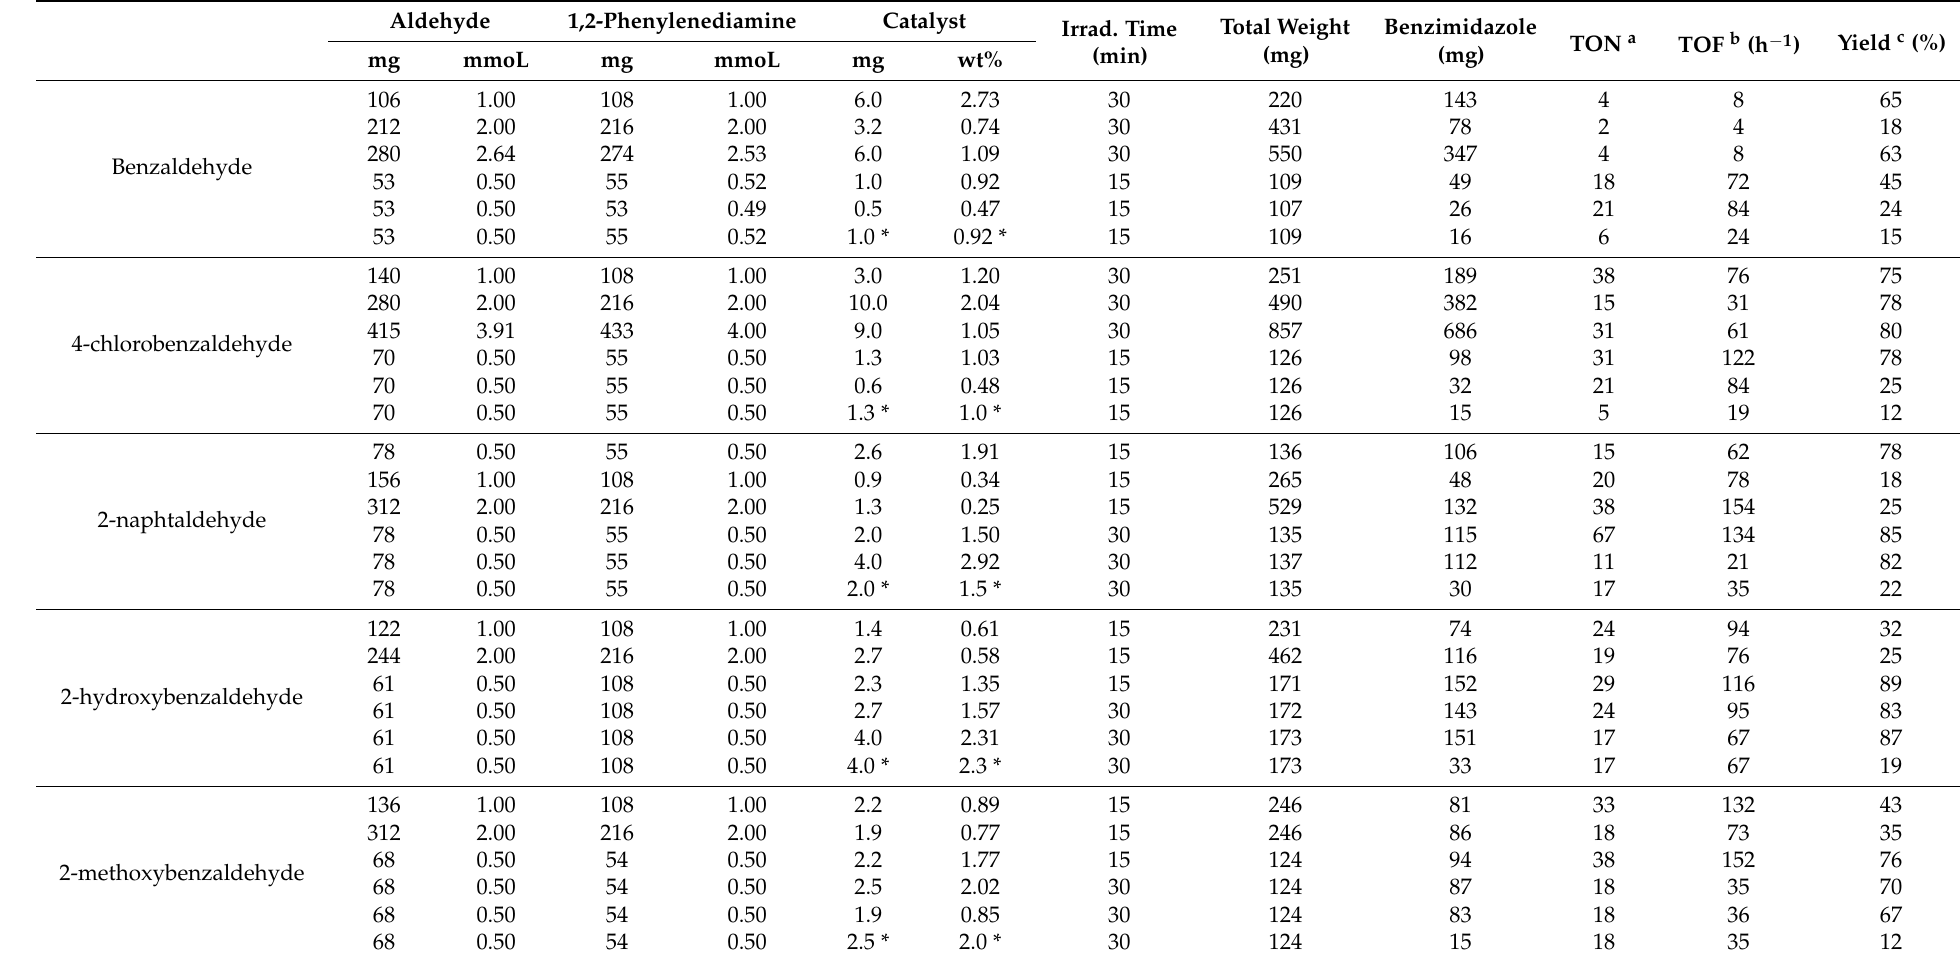
Table 4. Photocatalytic conditions for the synthesis of benzimidazoles using F,O,S-codoped g-C 3 N 4 vs. pristine g-C 3 N 4 (indicated with an